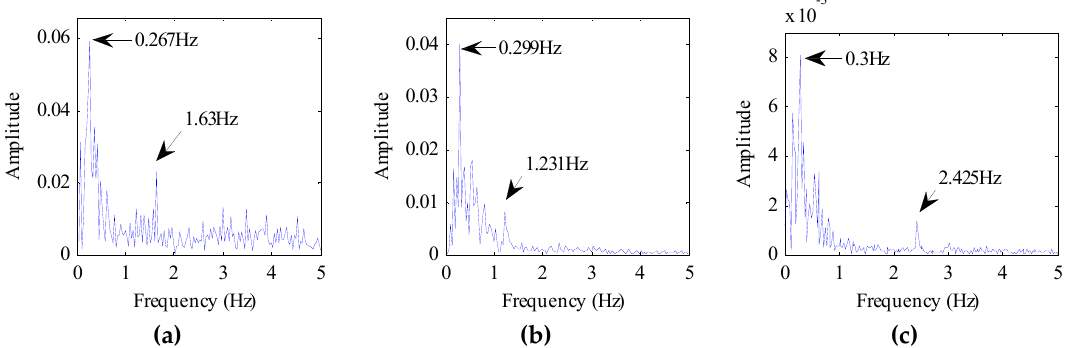
Figure 9. The spectrum of target vital signs. ( a ) Target is 1 m away from the radar; ( b ) Target is 2 m away from the radar; ( c ) Target is 3 m away from the radar.